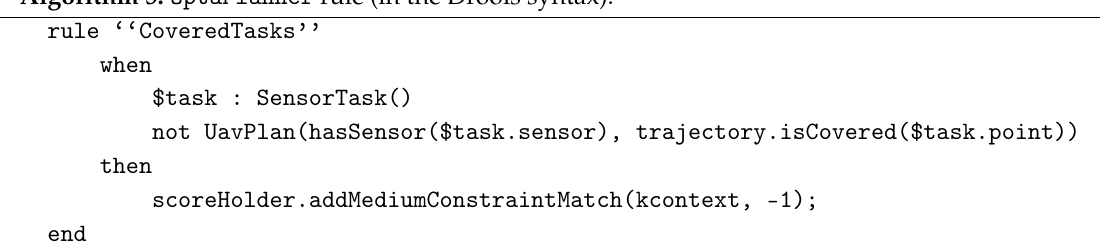
Algorithm 5: OptaPlanner rule (in the Drools